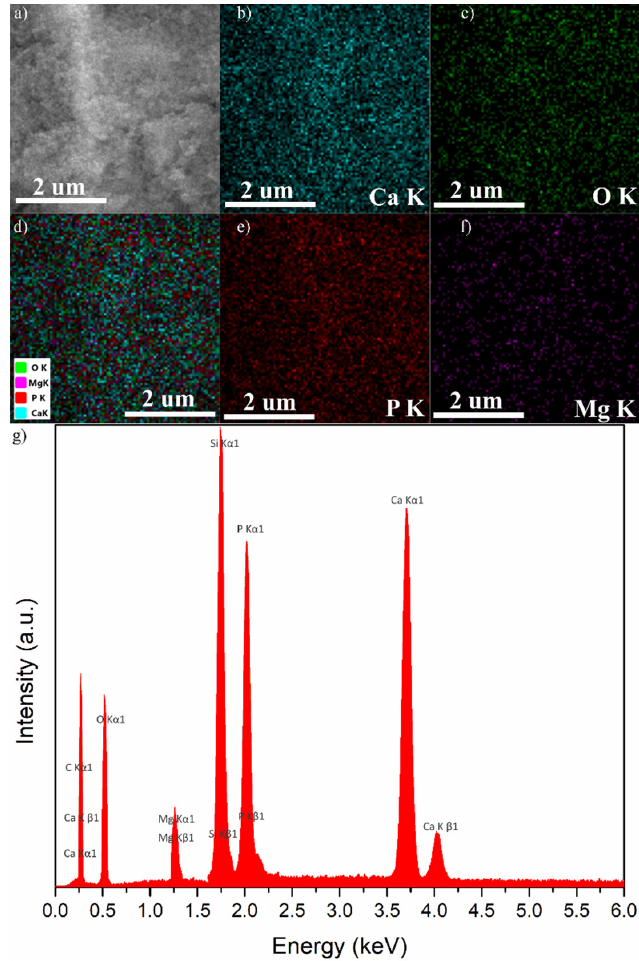
Figure 9 . SEM image ( a ), mapping analysis of Ca ( b ), P ( c ), Mg ( d ), O ( e ), superposition of all constituent elements ( f ), and EDS spectra ( g ) of the 25MgHAp coatings surface.